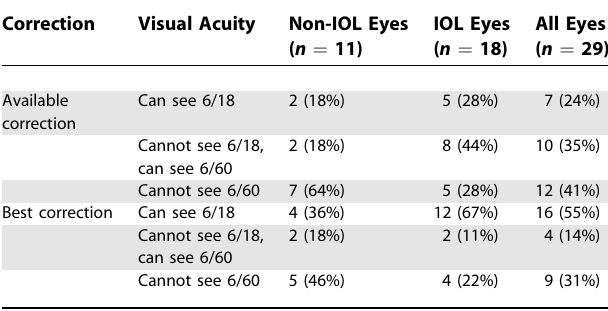
Table 4. Cataract Surgical Coverage by Person and Eyes in People Aged 50 Years and Older (Best Correction) Visual Acuity